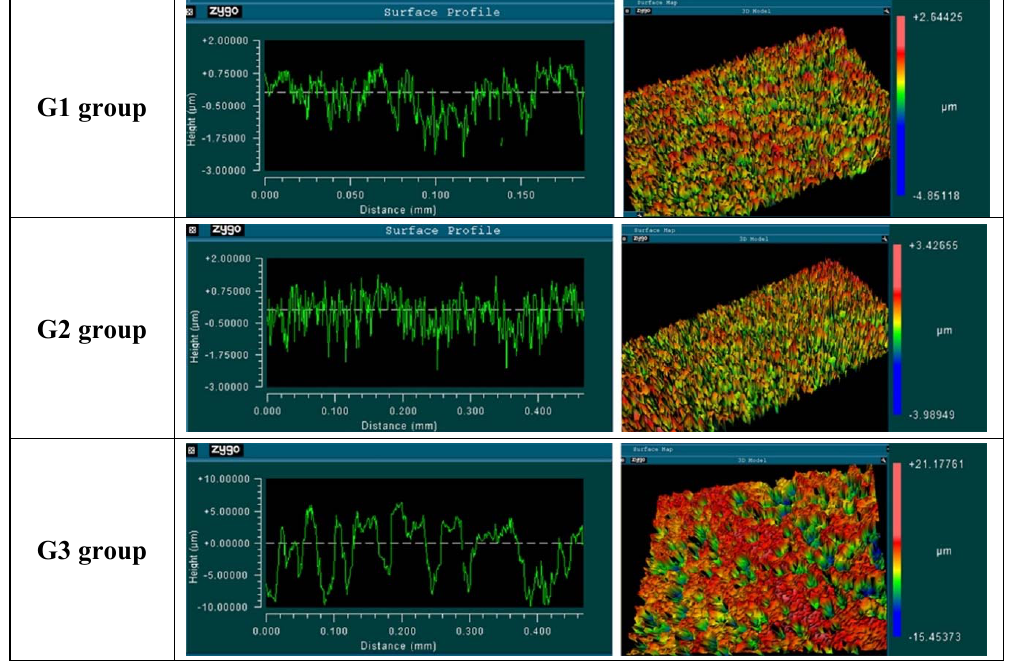
Figure 5. Representative AFM images of the surface sample of G1 group, G2 group and G3